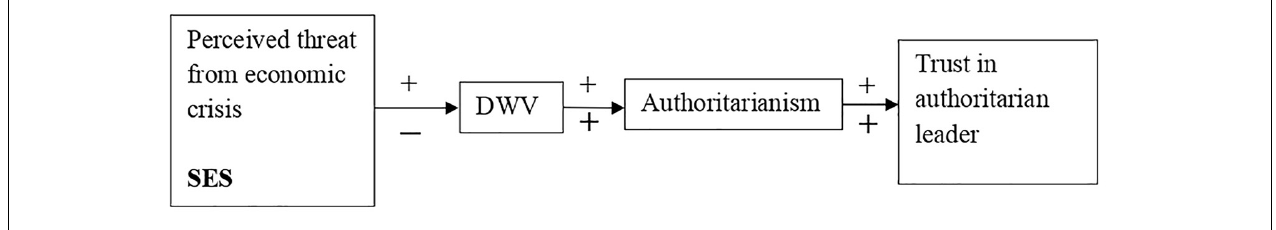
FIGURE 1 | Proposed model for the relationship between the macrosocial variables (economic crisis and SES) and trust in an authoritarian political leader, through dangerous worldview (DWV) and authoritarianism.